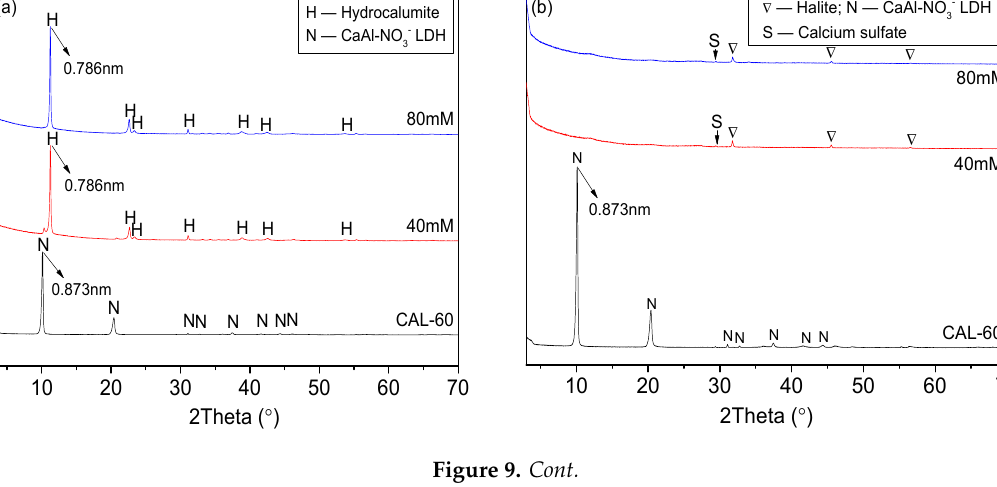
Figure 8. Effect of interference anions (i.e., OH − , CO 32 − and SO 42 − ) on chloride uptake of CAL-60 (temperature = 25 °C; CAL/NaCl solution = 10 g/L; initial chloride ion concentration and pH was set as 80 mmol/L and 7, respectively).